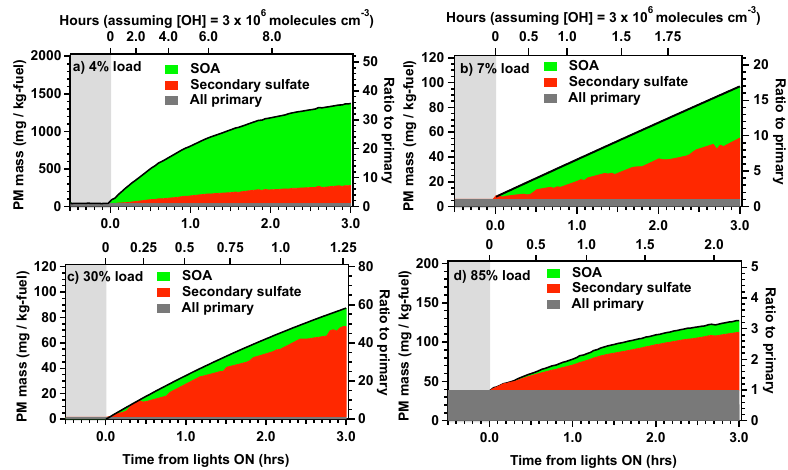
Fig. 5. Measured changes in the PM mass (secondary organics and secondary sulfate) caused by photo-oxidation for four engine loads: (a) 4% load, (b) 7% load, (c) 30% load, (d) 85% load. The data have been wall-loss corrected. Top axis indicates time for OH exposure assuming a constant OH concentration of 3 × 10 6 moleculescm − 3 . The ratio of secondary-to-primary PM mass is plotted on the right axis. Note different scales on each panel.